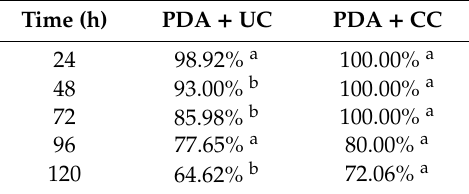
Table 2. Pythium ultimum inhibition according to the time course.